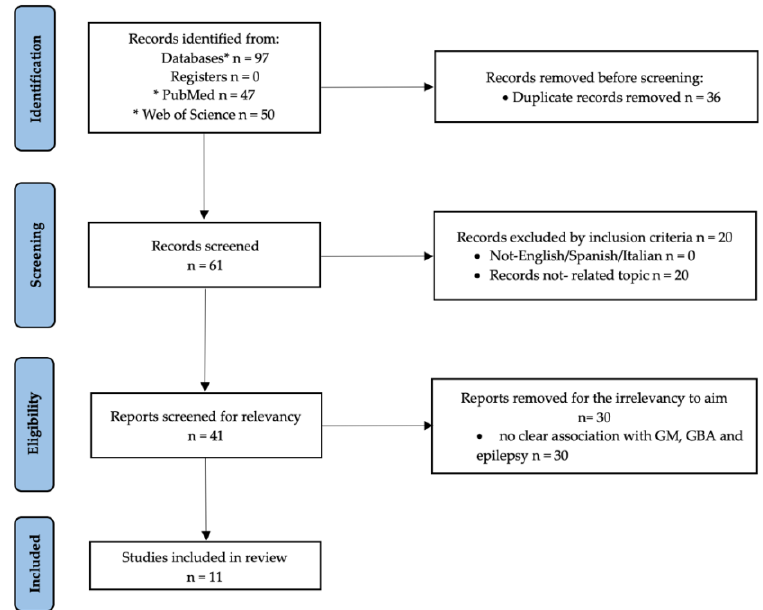
Figure 1. Study selection based on PRISMA flowchart .